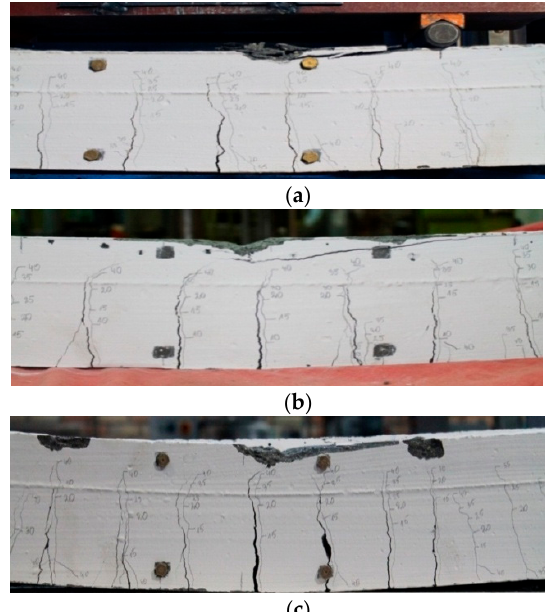
Figure 5. Crack shaping and development in the test samples: ( a ) HPC-HSC; ( b ) REC-1; ( c ) REC-2.